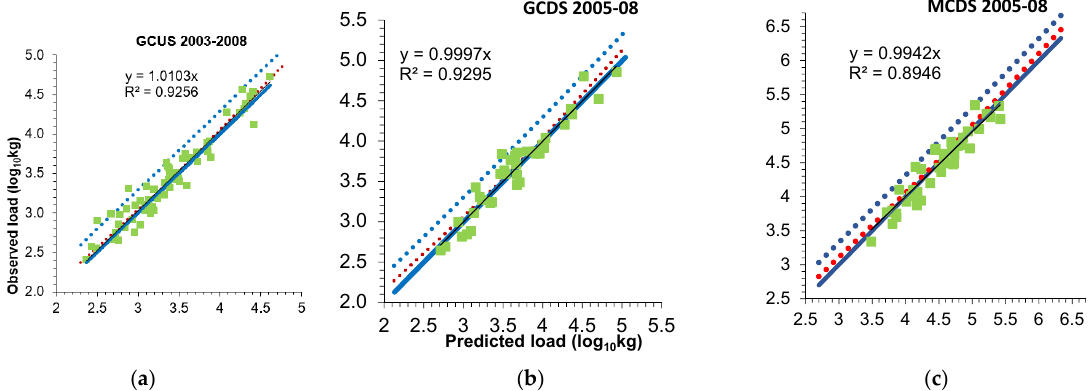
y = 0.9997x R² = 0.9295